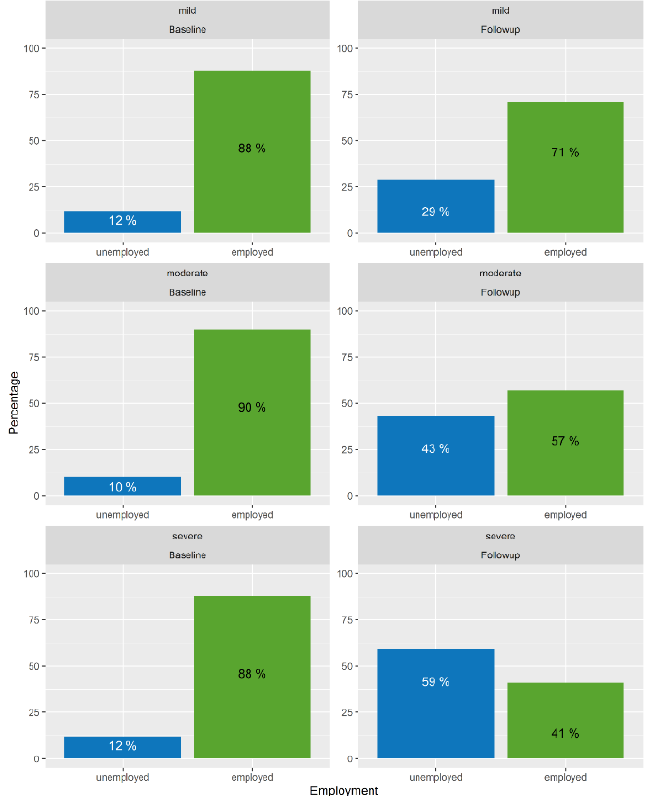
Figure 3. Employment rates at the baseline and one year after TBI by TBI severity groups.